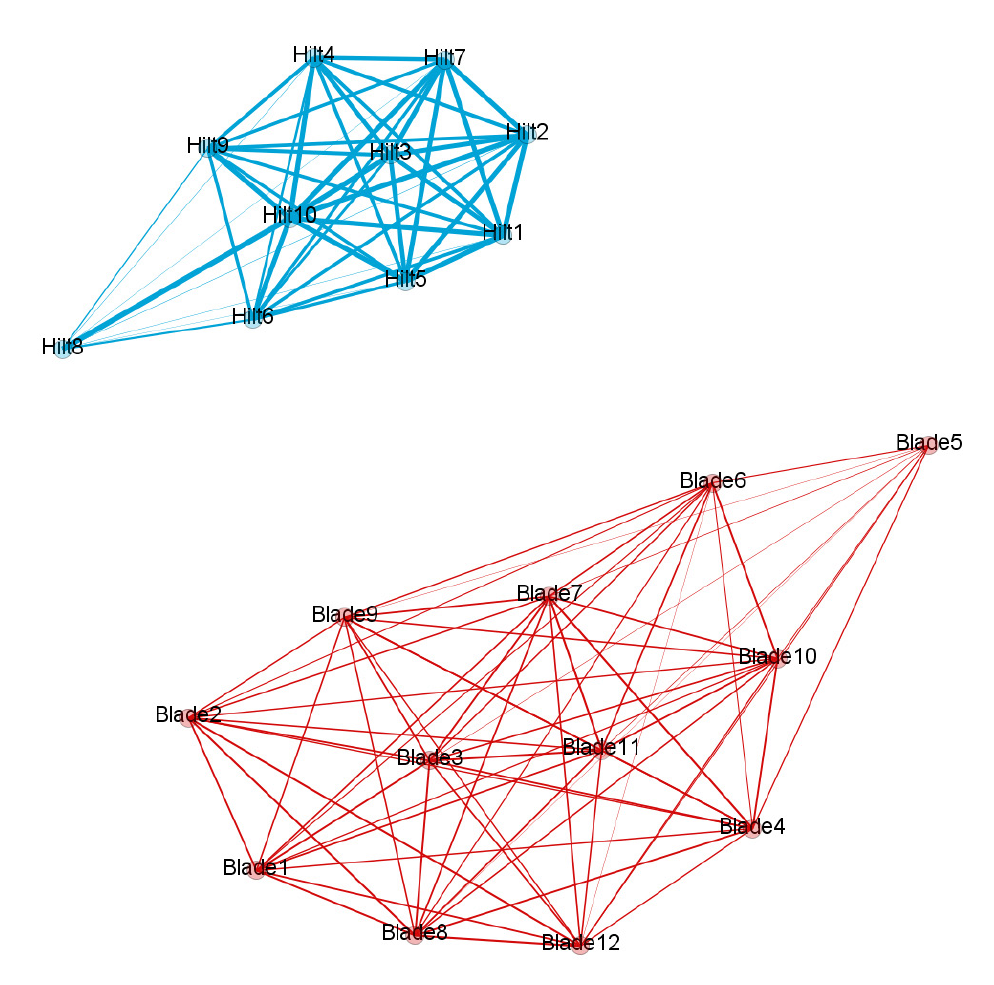
Figure 9. Network graph of hilt clusters (blue) and blade clusters (red) using the Force Atlas